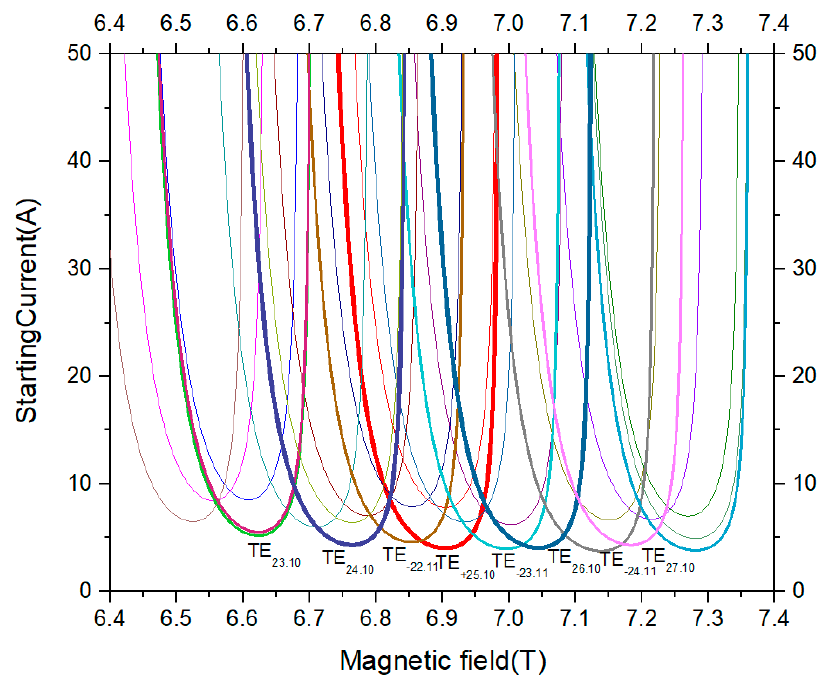
Figure 2. Starting current versus magnetic field for various modes operated at the nominal design parameters of the 170 GHz gyrotron.